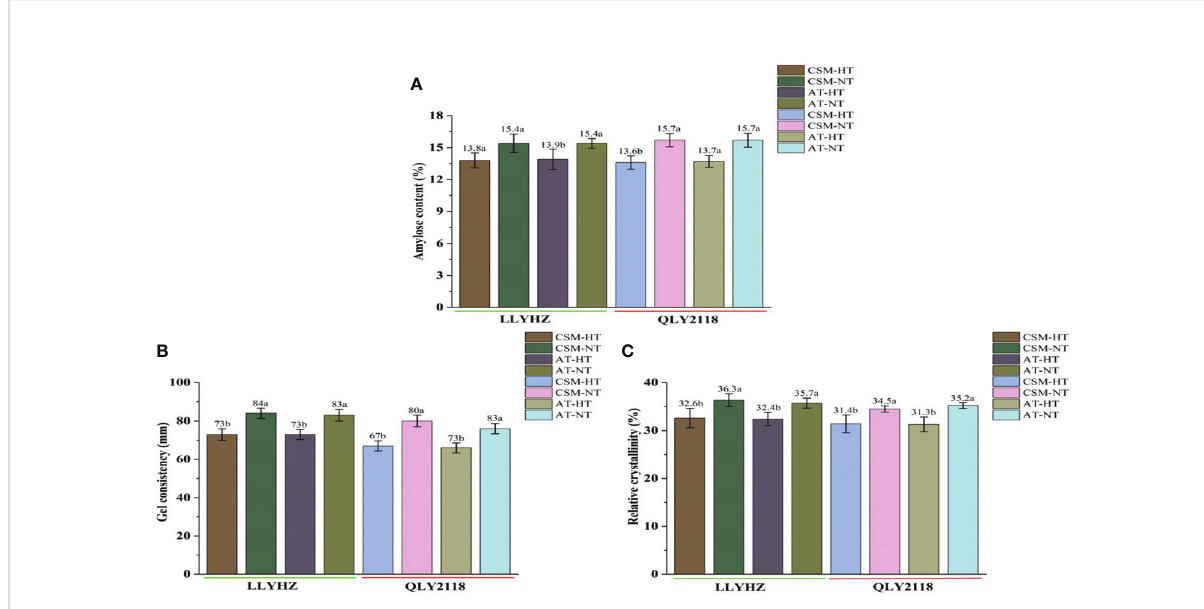
FIGURE 4 Effect of high temperature on grain quality of two rice cultivars. (A) Amylose content of the grains. (B) Gel consistency of the grains. (C) Relative crystallinity of the grains. Bars with different lowercase letters indicate a signi fi cant difference (LSD test, p < 0.05). Error bars indicate the SD of three biological replicates. LLYHZ, Longliangyou Huazhan; QLY2118, Quanliangyou 2118; CSM, carpet seedling mechanical transplantation; AT, manual transplanting; HT, high temperature; NT, normal